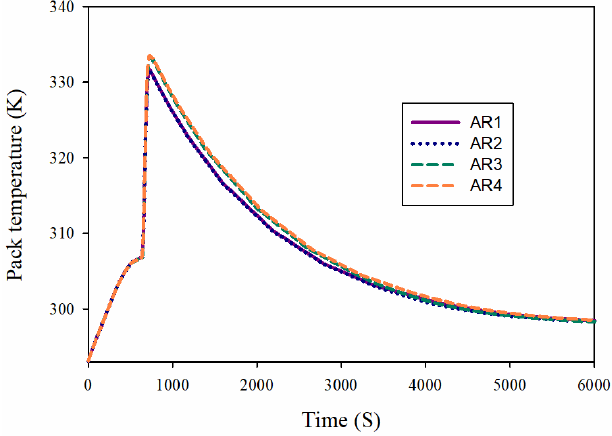
Figure 9. TOB pack for different values of cavity AR up to 6000 s.